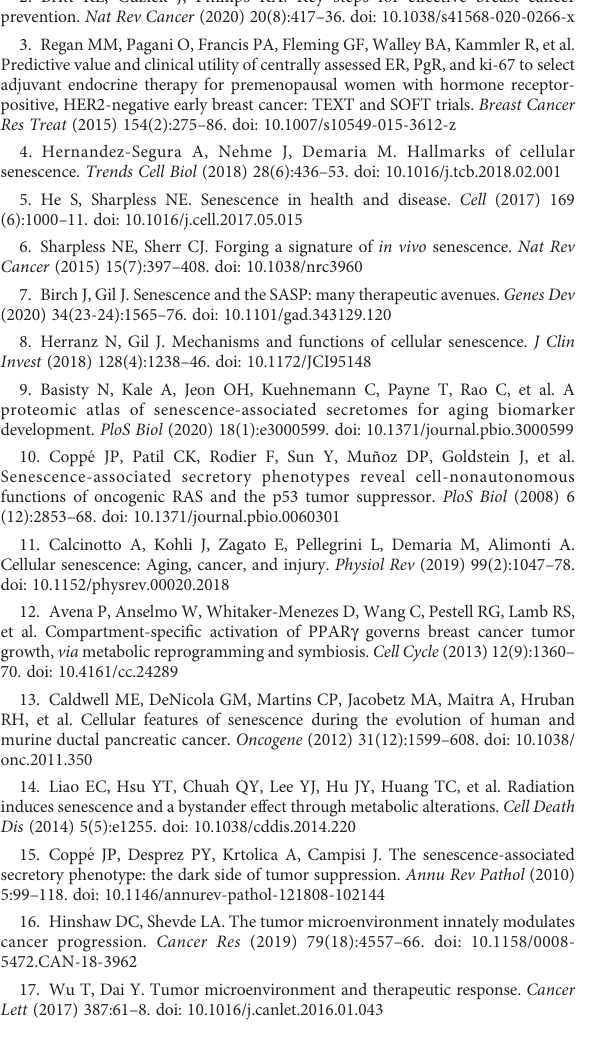
SUPPLEMENTARY FIGURE 1 MultivariateCoxanalysisforpatientsaccordingtothesenescence-related subtype strati fi ed by clinicopathological risk factors. (A, B) tumor size, (C, D) tumor grade, (E, F) Tipple-negative breast cancer.